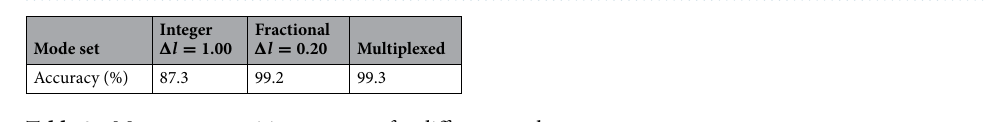
Table 3. Measure recognition accuracy for different mode